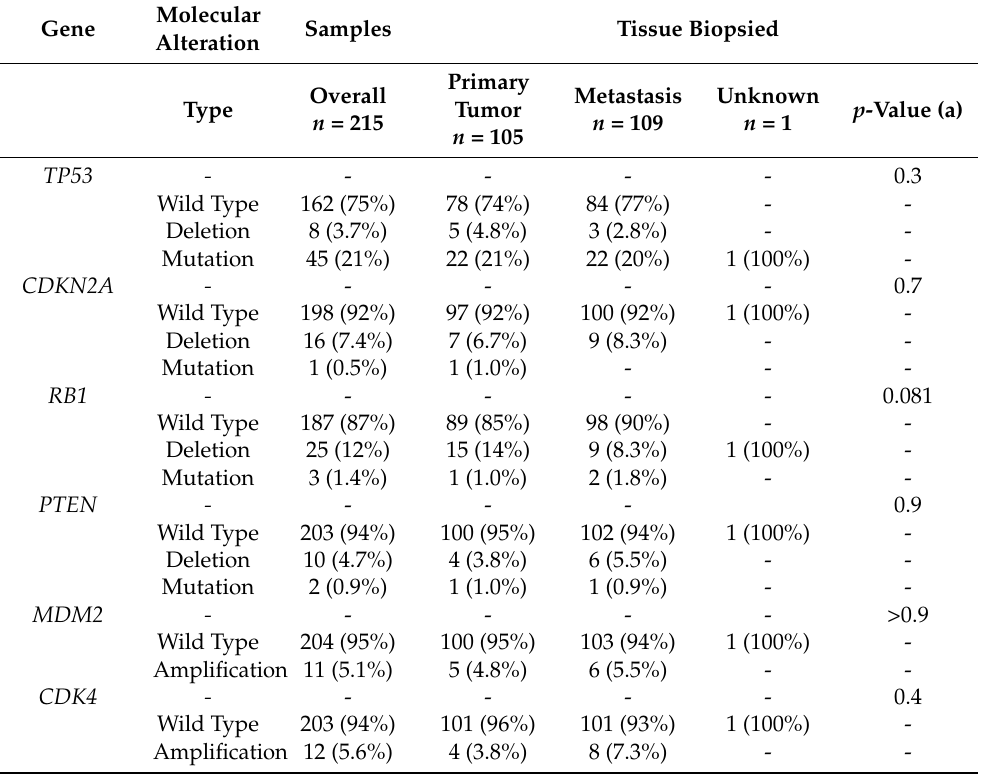
Table 1. Molecular description of the cohort: the six most frequently altered genes in the cohort, the alteration types, and their distribution according to the tissue type